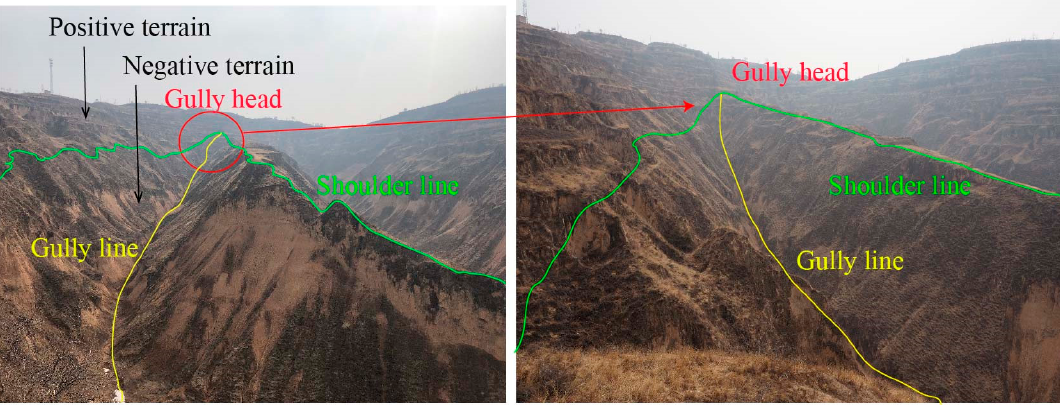
Figure 2. Example of a gully head in the research area.